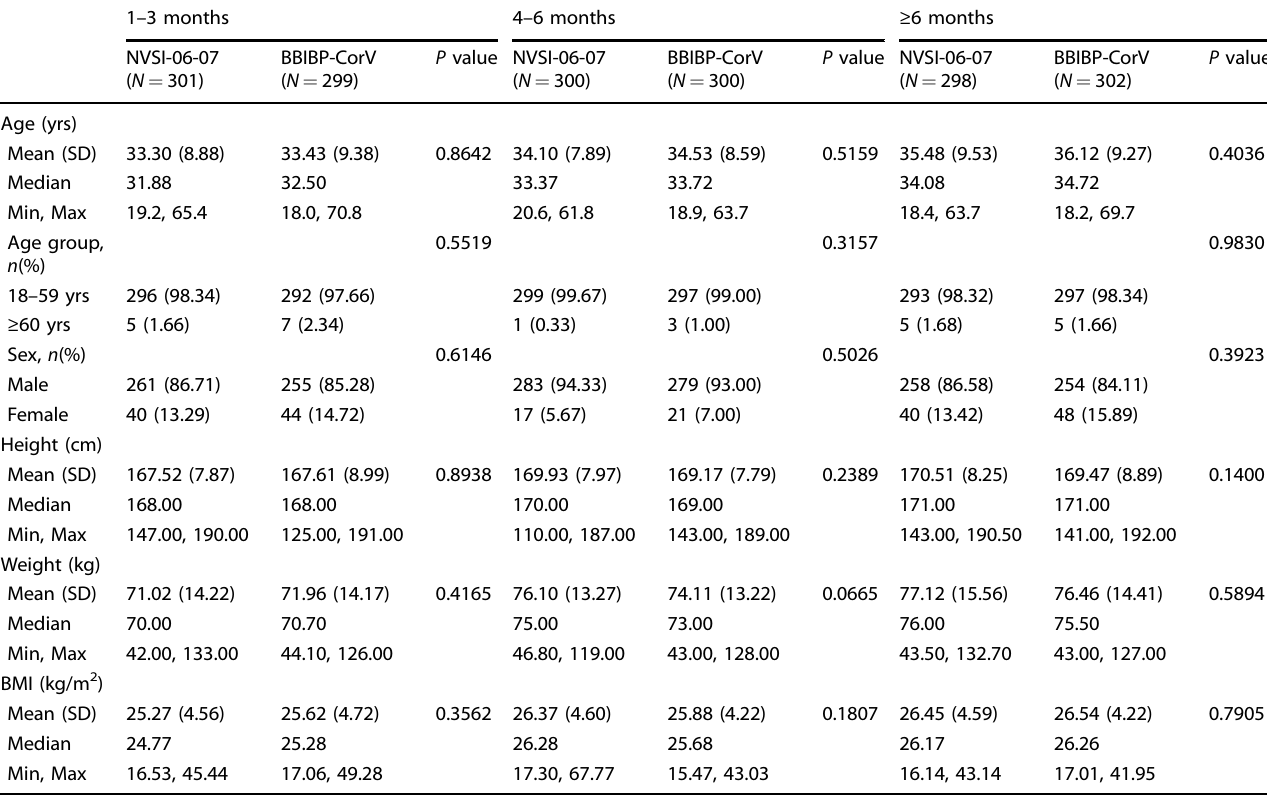
Table 1. Demographic characteristics of the participants